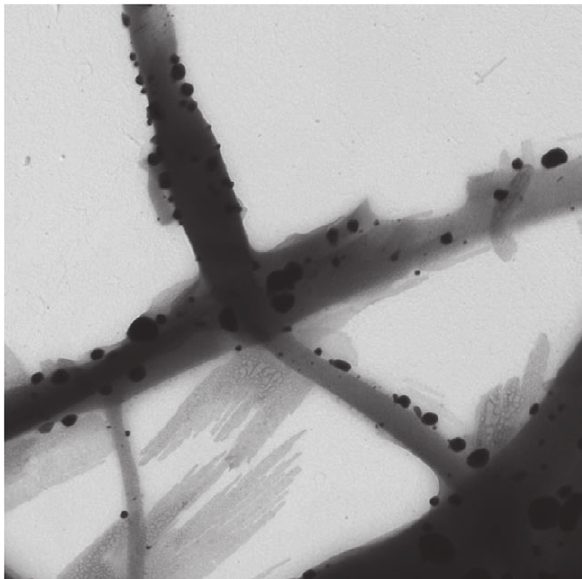
Figure 2 TEM image of Ag NP-loaded electrospun fiber